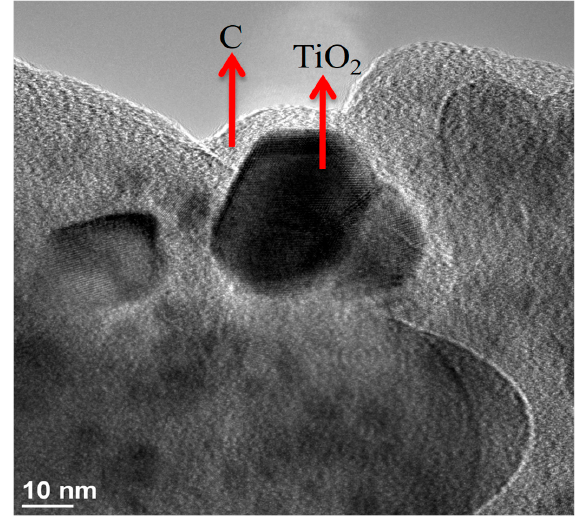
Figure 5. TEM image of C–TiO 2 film synthesized in 300% glucose solution.